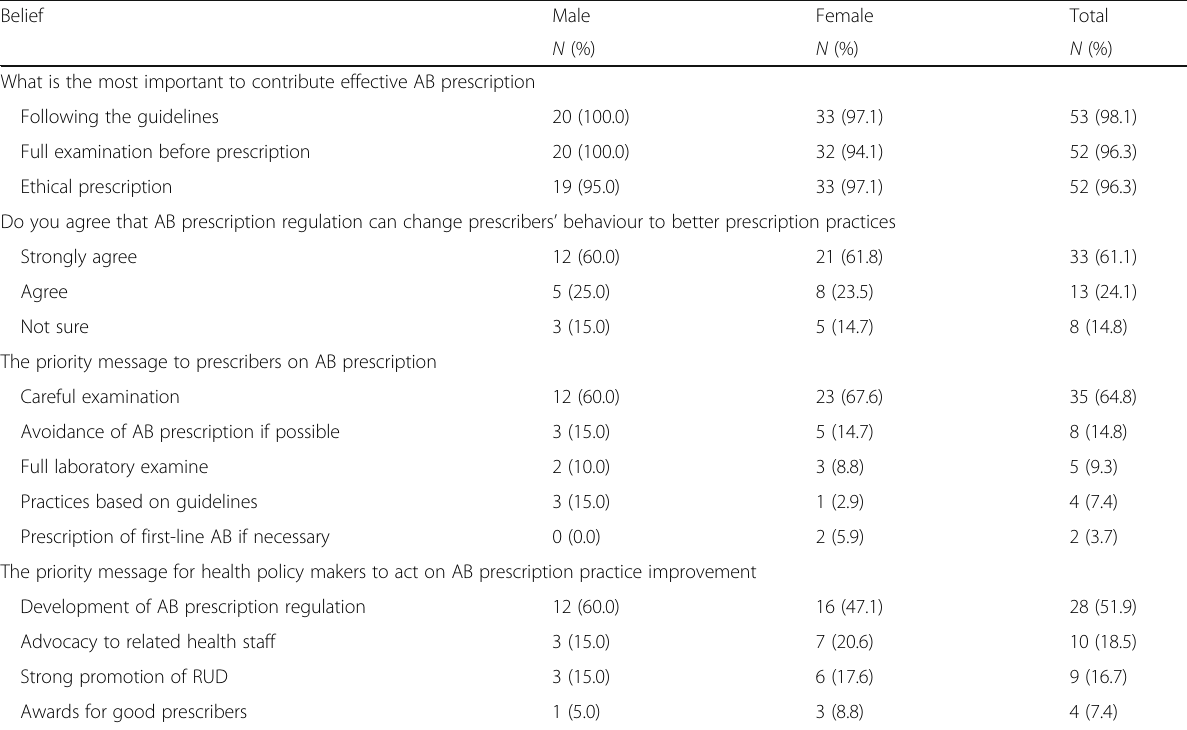
Table 4 Belief in antibiotic prescription practices among healthcare providers (20 males and 34